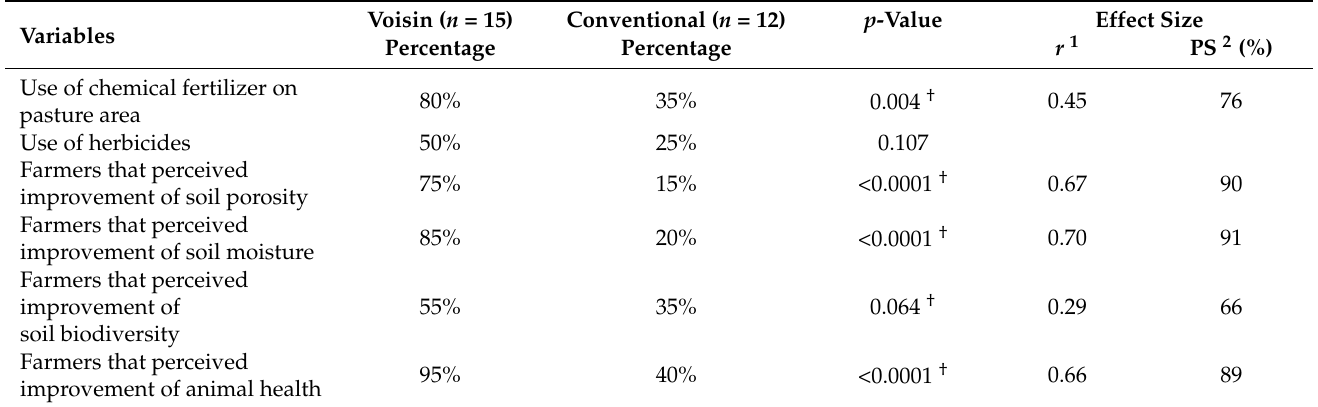
Table 1. Percentage of farmers that use agrochemicals and perceived improvement of soil quality, biodiversity, and animal health during the ten years prior to the